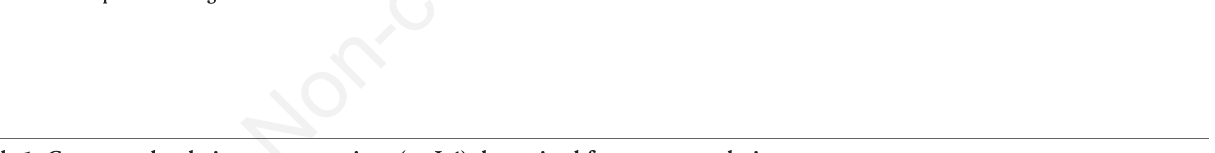
Figure 1. Percentages (mean±SEM) of fertilization success after gamete exposure to (A) copper or (B) cadmium for 30 min. Asterisks indicate statistical differences between con- trol and exposed treatments at *P<0.05, **P<0.01,